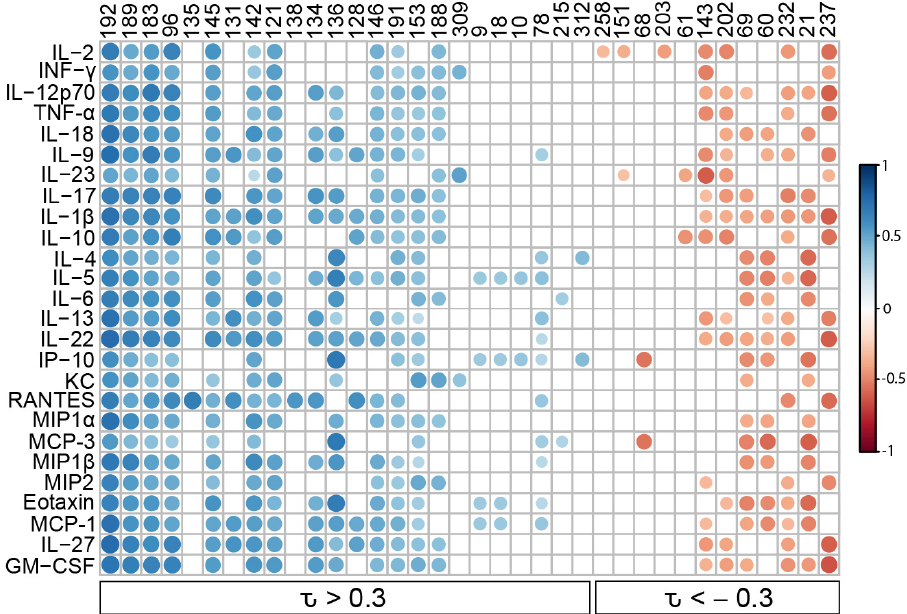
Figure 3. A subset of the volatilome is correlated to the cytokines in BALF. Kendall correlations were calculated between the VOCs and the cytokines in BALF of 12 Cocci-inoculated and 4 PBS-inoculated mice. This Kendall correlation plot represents the 36 volatile organic compounds (VOCs) (columns) that are significantly correlated with at least one of the 26 cytokines (rows). Circles indicate statistically significant correlations ( p < 0.05), with positive correlations in blue ( τ > 0.3), negative correlations in red ( τ < − 0.3), and darker colors and larger sizes indicating a stronger correlation. The volatiles are ordered by mean correlation from most positive ( left ) to most negative ( right ). Addi- tional information about the VOCs, including putative identities, is provided in Supplementary Ta- ble S3.